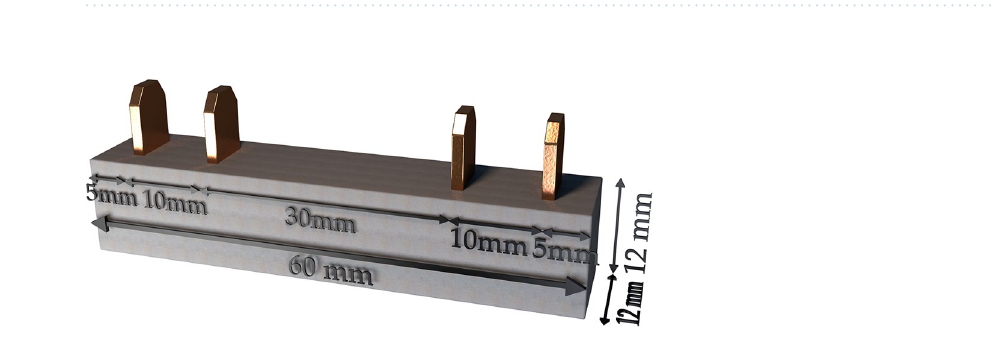
Figure 2. Mortar specimen with four electrodes. This figure was created using Sketchup version 2017 (https:// www. sketc hup. com), Microsoft PowerPoint version Microsoft 365 (https:// www. micro soft. com/ en- us/ micro soft- 365/ power